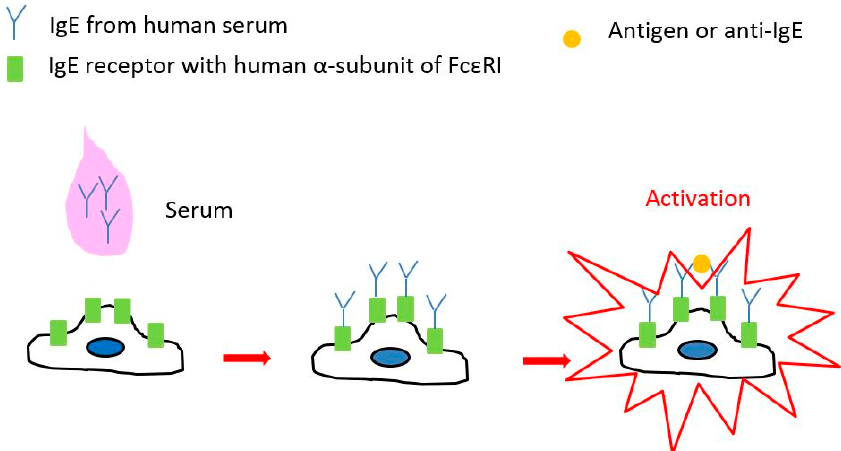
Figure 4. Schematic of RBL-48 cells activation. Serum IgE antibodies in a patient bind to IgE receptors on the surface of RBL-48 cells. Cross-linkage of IgEs by anti-human IgE antibodies or multivalent antigens induces the activation of RBL-48 cells.